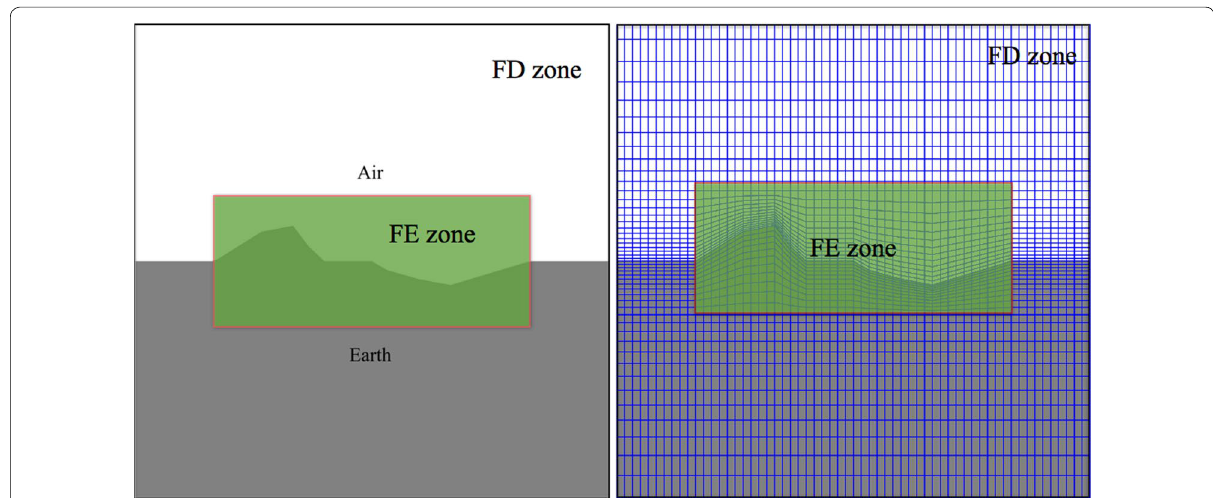
Fig. 3 The model with setting of the FD and FE zones (left). The FE zone is set and optimized for the terrain zone (light green), whereas the FD zone is set for the simple zone without terrain. Design of the mesh of the FD and FE zones (right). Quadrilateral elements are used for the FE zone, whereas rectangular blocks are used for the FD